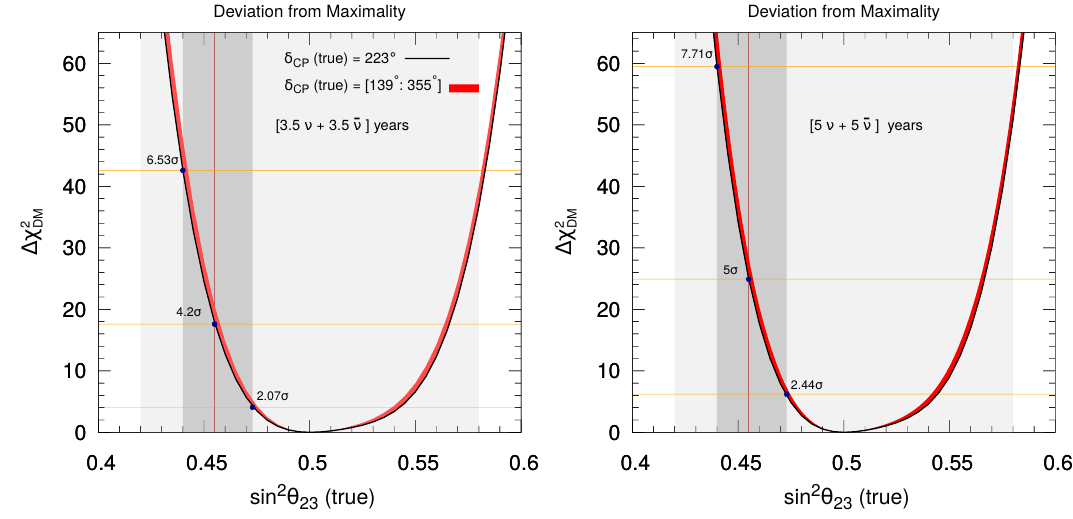
Figure 6 . The black curve in the left (right) panel shows the potential of DUNE to establish the deviation from maximal θ as a function of true sin 2 θ assuming true NMO and δ (true) = 223 ◦ 23 23 CP with 7 (10) years of total exposure equally divided in ν and ¯ ν modes. The red bands portray the same for true δ in the range of 139 ◦ to 355 ◦ . In the fit, we marginalize over the current 3 σ range CP of ∆ m 2 and δ , while keeping rest of the oscillation parameters fixed at their present best-fit CP 31 values as shown in table 1. The dark (light)-shaded grey area shows the currently allowed 1 σ (2 σ ) region in sin 2 θ as obtained in the global fit study [11] with the best-fit value of sin 2 θ = 0 . 455 23 23 as shown by vertical brown line. The horizontal orange lines show the sensitivity (experessed in p ∆ ) for the current best-fit and 1 σ upper and lower bounds of sin 2 θ . σ = χ 2 23 DM